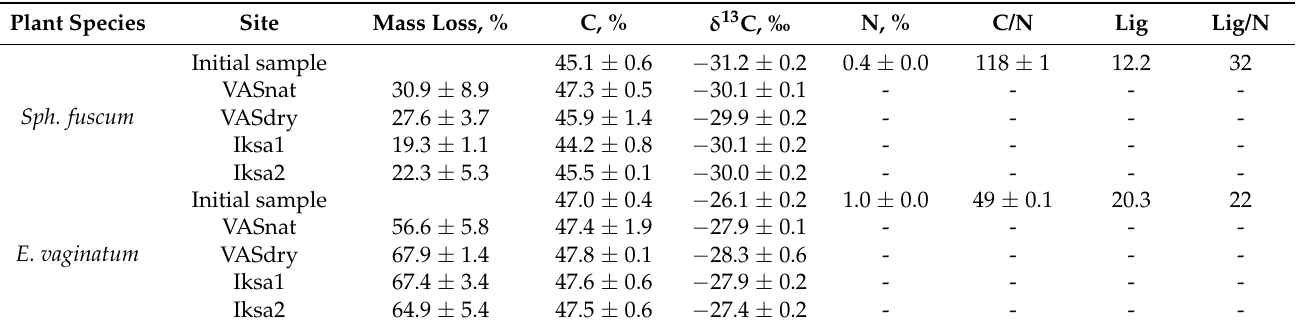
Table 1. Percentage of mass loss and chemical composition in initial samples and after 3 years of field decomposition.